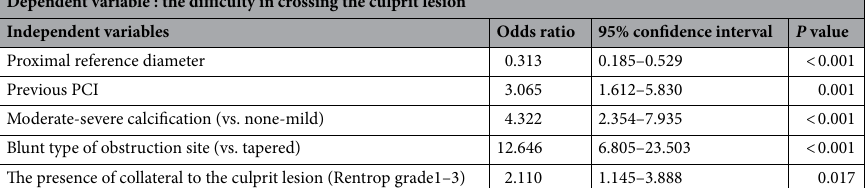
Table 3. Multivariate logistic regression analysis model to find association with the difficulty in crossing the culprit lesion. The stepwise model includes the following variables: age, proximal reference, previous PCI, number of diseased vessels, initial TIMI flow grade of culprit, calcification, type of obstruction site, the presence of collateral to the culprit lesion, In-stent lesion, TIMI thrombus